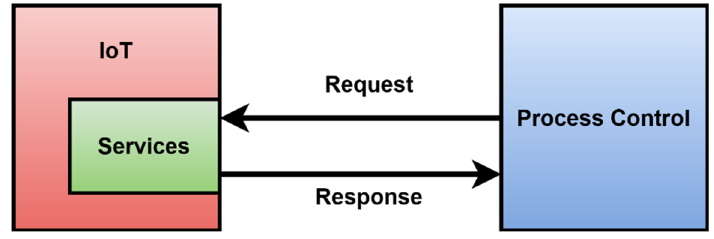
Figure 2. Model of common integration IoT in industry.